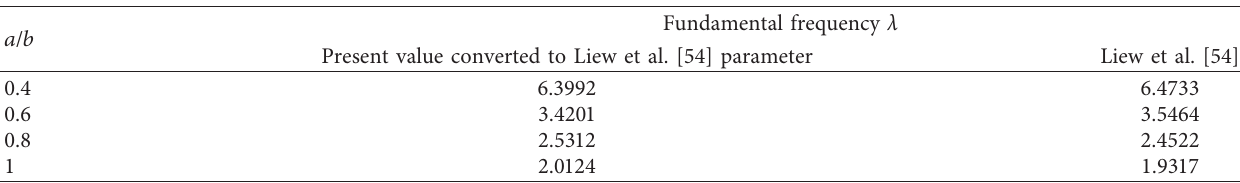
Table 2: Comparison of fundamental frequency parameter of S-S plates with frequency parameter of Liew et al. [54] λ � ( ω b 2 / π 2 ) t / b � 0 .